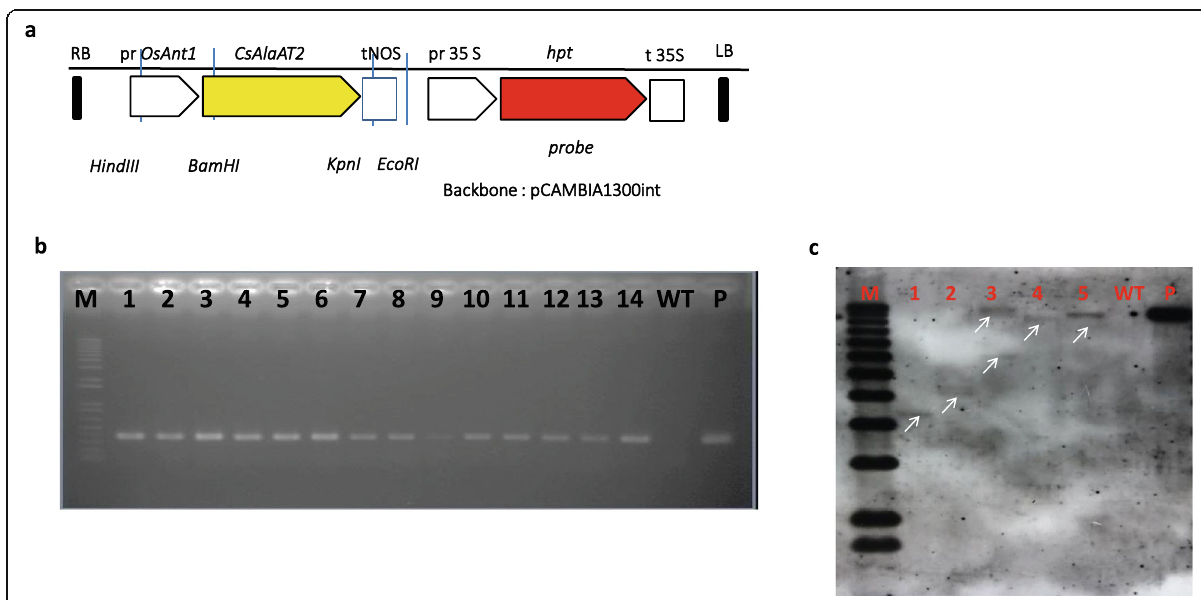
Fig. 1 Development and molecular characterization of CsAlaAT2 transgenic rice event. a Schematic diagram of the T-DNA construct OsAnt1::CsAlaAT2 , containing the CsAlaAT2 gene with the NOS terminator under the control of the OsAnt1 promoter. RB, right border; pr OsAnt1 , promoter antiquitin1; CsAlaAT2 , Cucumis sativus Alanine aminotransferase ; tNOS, terminator Nopaline synthase; pr 35 S, promoter 35 S; hpt, hygromycin phosphotransferase; C35S, cauliflower 35 S; LB, left border. b PCR amplification of cucumber AlaAT on T0 transgenic rice lines. M = 1 kb DNA ladder plus; 1 – 14 = transgenic lines, WT = wild type, P = plasmid control. c Southern blot analysis showing the copy number of hpt gene insertion in the T0 generation of transgenic lines. Hpt gene insertion is shown by white arrow. M = marker 1 kb ladder, WT = wild type, 1 = FAM3, 2 = FAM4, 3 = FAM5, 4 = FAM 9, 5 = FAM13, P = plasmid of pCAMBIA1301-